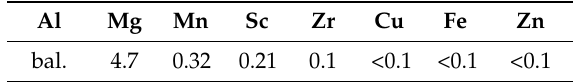
Table 1. Chemical composition of the investigated alloy 1545 K, mass